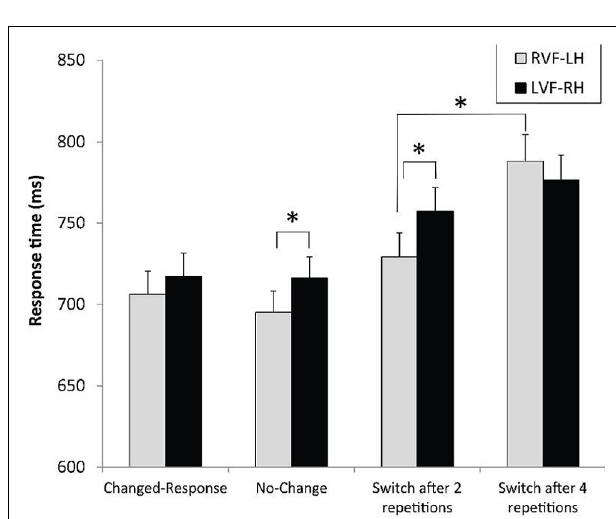
FIGURE 5 | Mean response times and standard errors for letter-based and object-based hierarchical stimuli according to the context preceding the experimental trial and the visual field of presentation. * p <